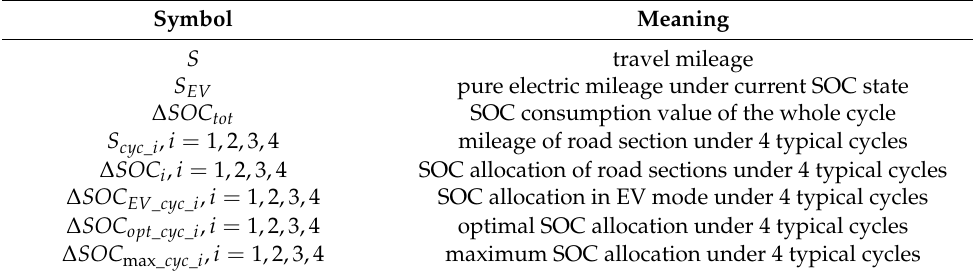
Table 4. Relevant